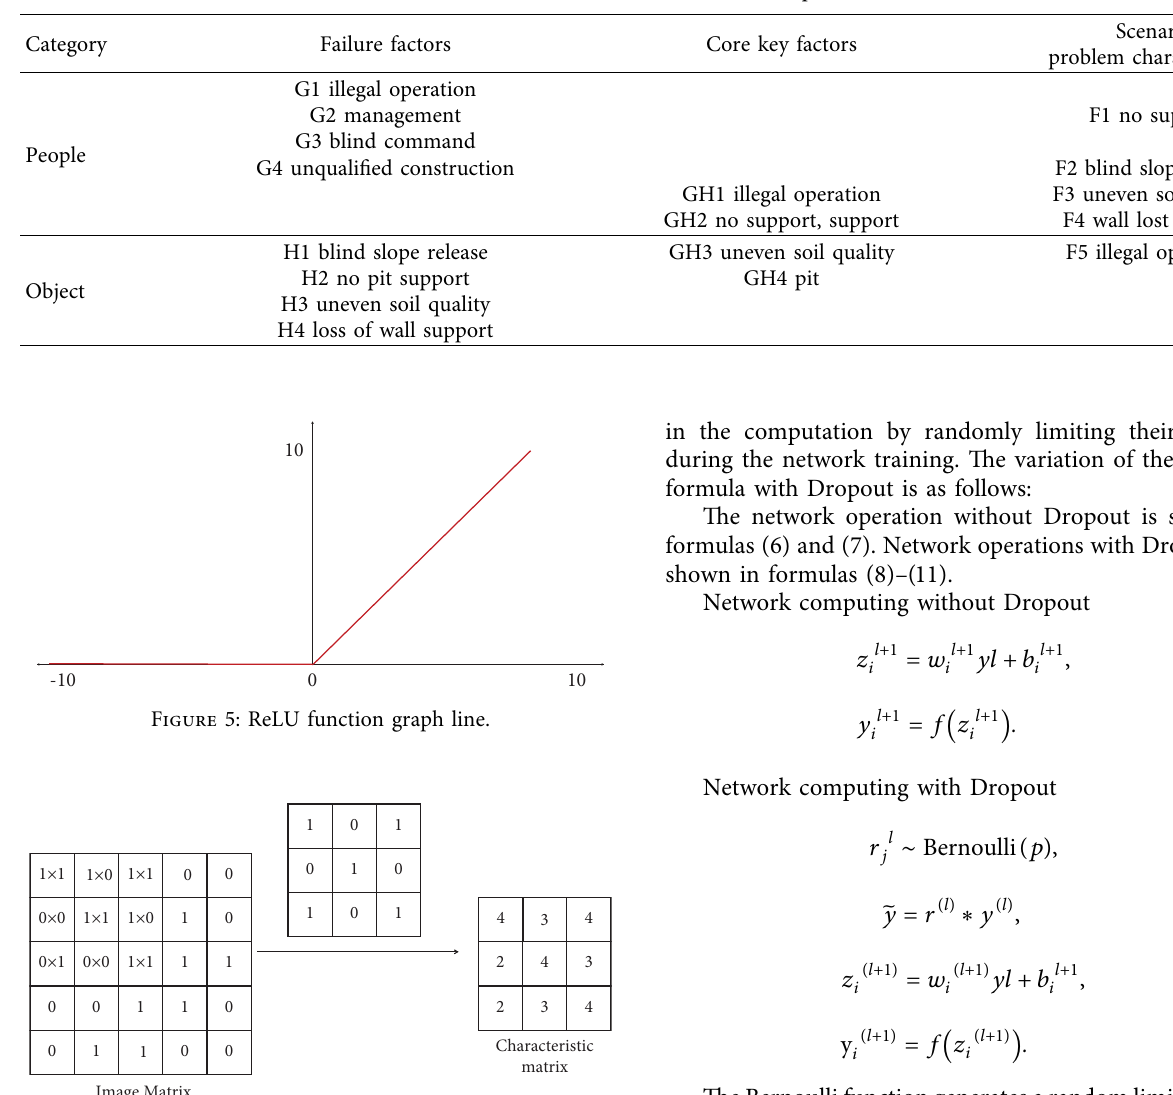
Table 4: Unsafe scenario characteristics of collapse accidents.